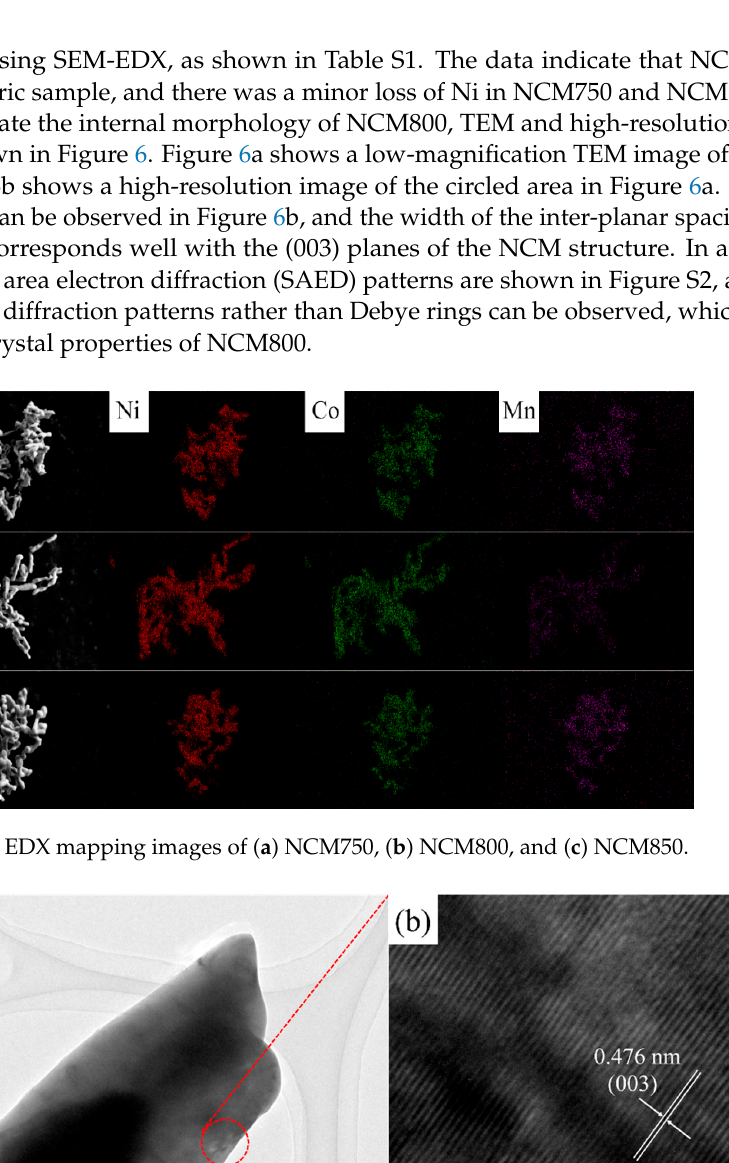
Figure 4. XPS spectra of Ni2p and O1s ( a , d ) NCM750, ( b , e ) NCM800, and ( c , f ) NCM850.